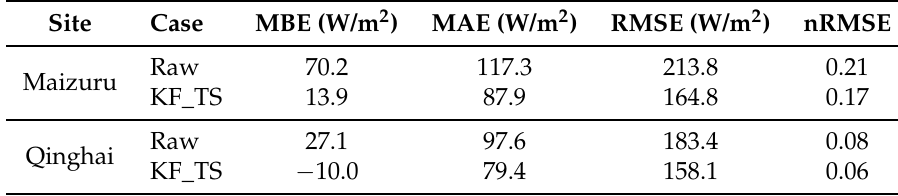
Table 3. Performance statistics of hourly WRF raw and KF_TS forecasts of solar radiation, respectively.